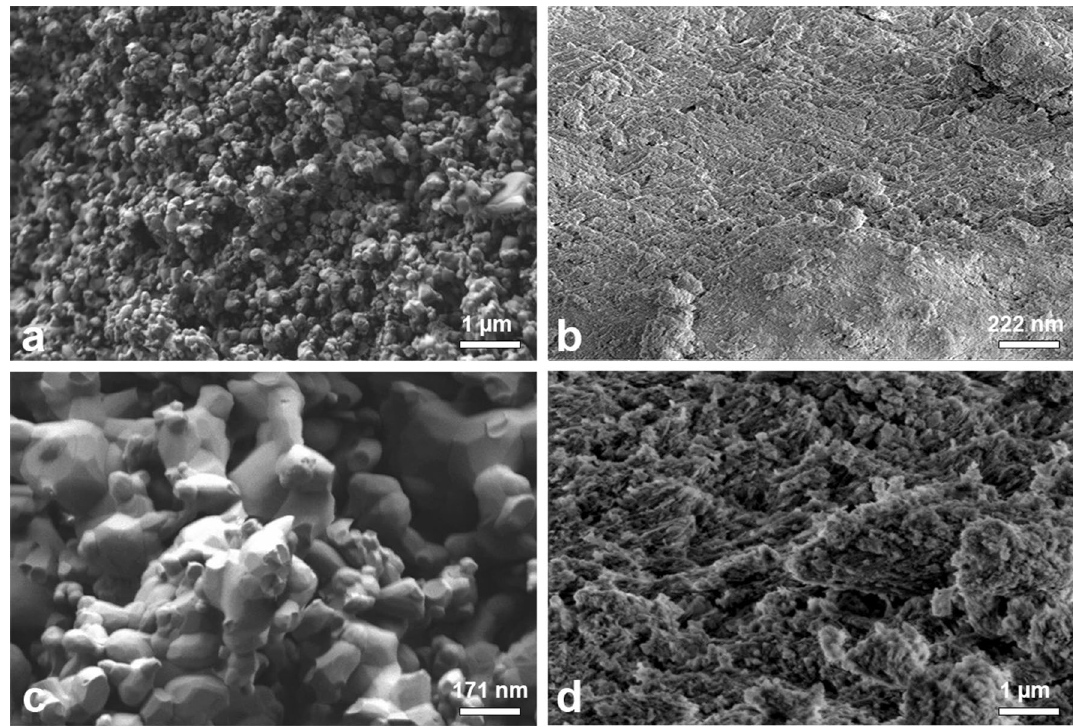
Figure 1. Representative scanning electron microscopy images of the surface structures of the biphasic materials Nanosynt ( a , c ) and xenogeneic Bio-Oss ( b , d ). Bars: ( a,d ) 1 µm; ( b ) 222 nm; ( c ) 171